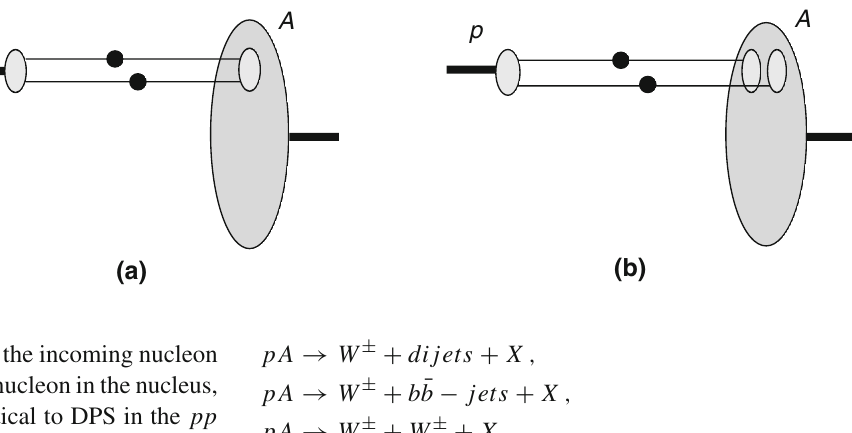
Fig. 1 Pictorial representation of DPS process in pA collisions via a DPS1 and b DPS2 mechanisms. The light grey blobs indicate nucleons, darker grey ones the nucleus and black ones the hard